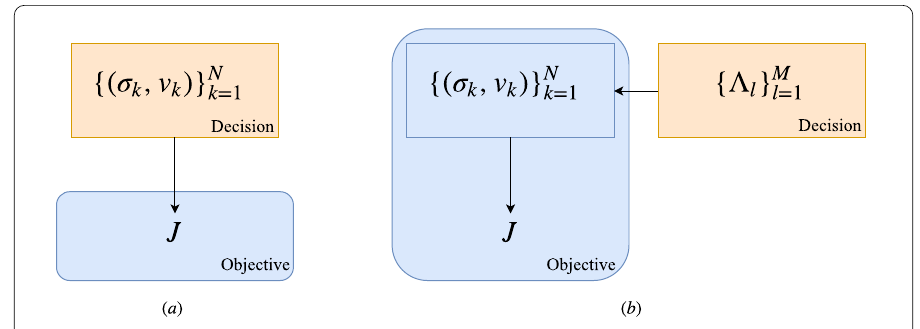
Figure 4 Difference between the two greedy algorithms. In the second version (b), the additional step significantly reduces the dimension of the decision vector if the number of lines is much smaller than the number of segments, i.e., if M (cid:12) N